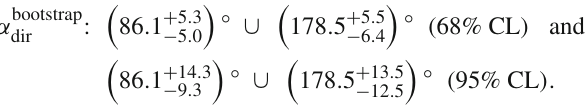
This direct α measurement within the bootstrap approach is consistent with the indirect CKM determination α ind at the level of 1.1 standard